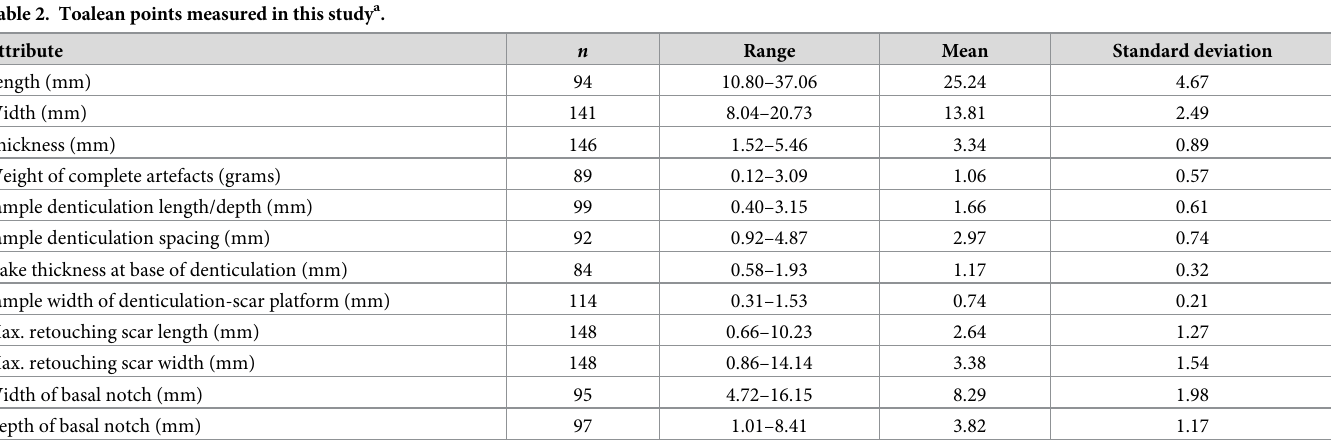
Table 2. Toalean points measured in this study a .